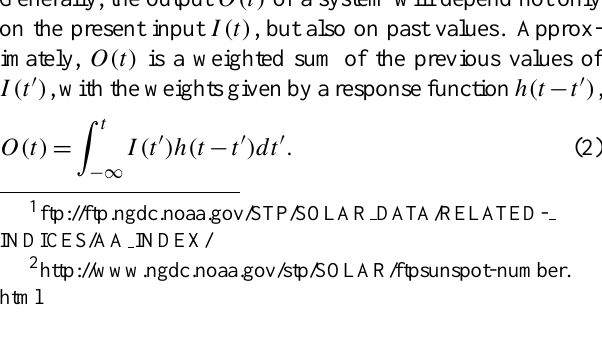
Fig. 1: aa − 5 (solid line, shifted downward by 5 for clarity) and R z (dashed) to the right of the vertical dash-dotted